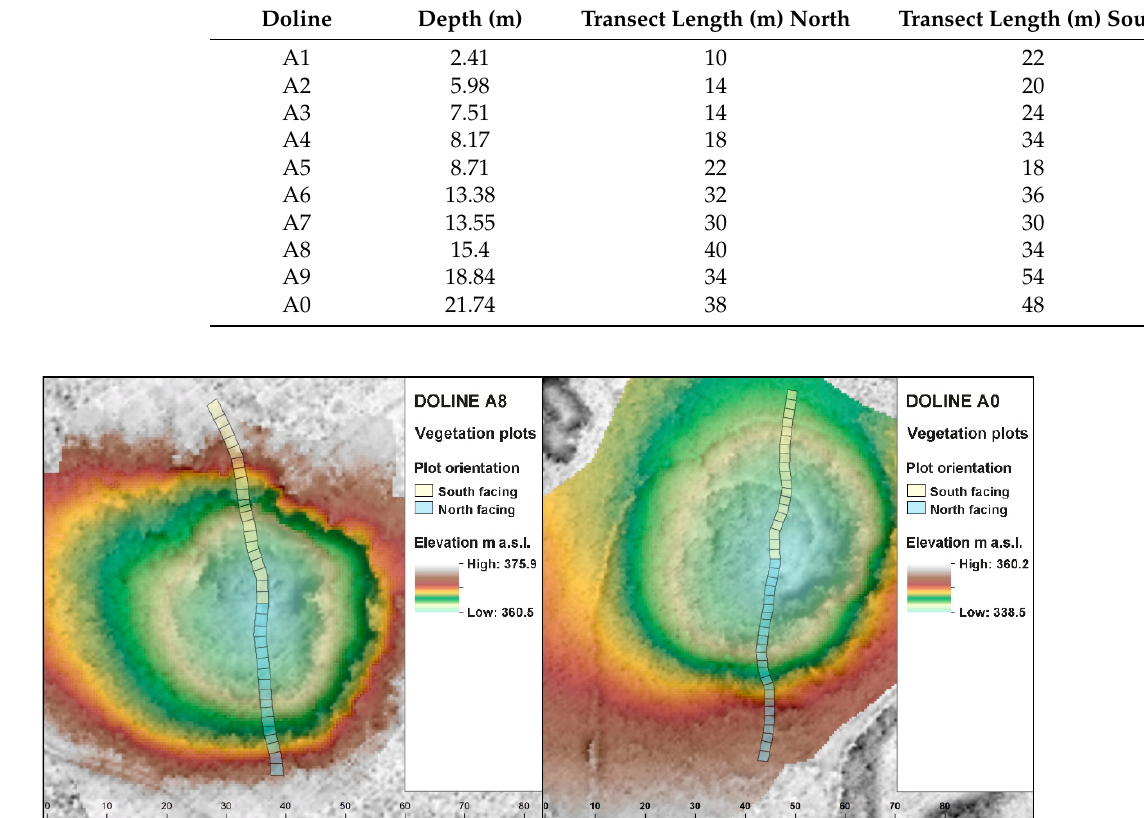
Figure 1. Sampling design with transect method by which the plant composition was sampled from the doline bottom to the top. Doline A8 and A0 are presented as examples of bigger dolines to visualize the ratio between doline depth and length of transects.